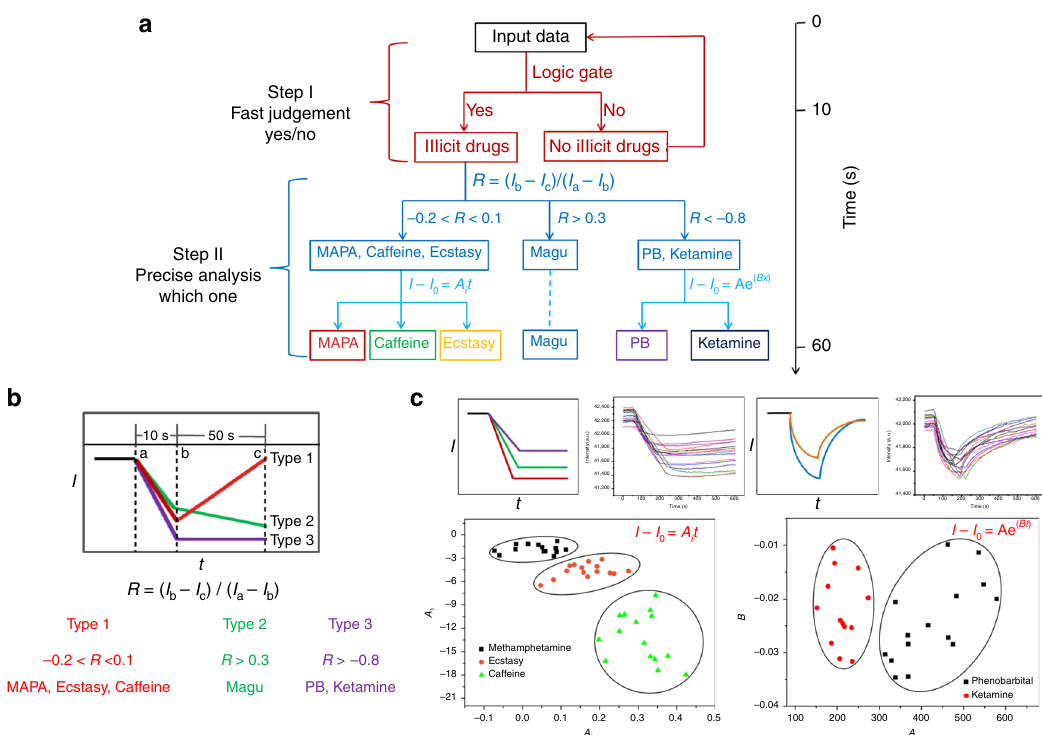
Fig. 5 Two-step discrimination of illicit drugs. a Logical judgment process to the presence of unknown sample via utilization of three fl uorescent fi lms, where a two-step strategy is used to identify and differentiate the samples under examination. In the fi rst step, which takes <10 s, combined use of two of the three fi lms will provide a “ yes ” or “ no ” answer, which tells if the sample is a target drug or not. In the second step, which takes a longer time but not more than 1 min, there are two stages to differentiate the chemical nature of the found drug in this step. b Schematic representation of the dynamic responses of fi lm 1 to the presence of different illicit drugs in vapor phase, of which the responses can be qualitatively grouped into three types. c Discrimination of the illicit drugs under examination, where a parameter R was introduced, which can be calculated in the way as depicted in b . Clearly, the detectable six drugs can be simply and ef fi ciently identi fi ed, indicating the strong discriminating ability of the fi lm. It is to be noted that the parameters R , A A A , and B for the illicit drugs were calculated from the traces of the 15 repetitive tests (Supplementary Fig. 4), and the detailed information is 1 , 2 ,